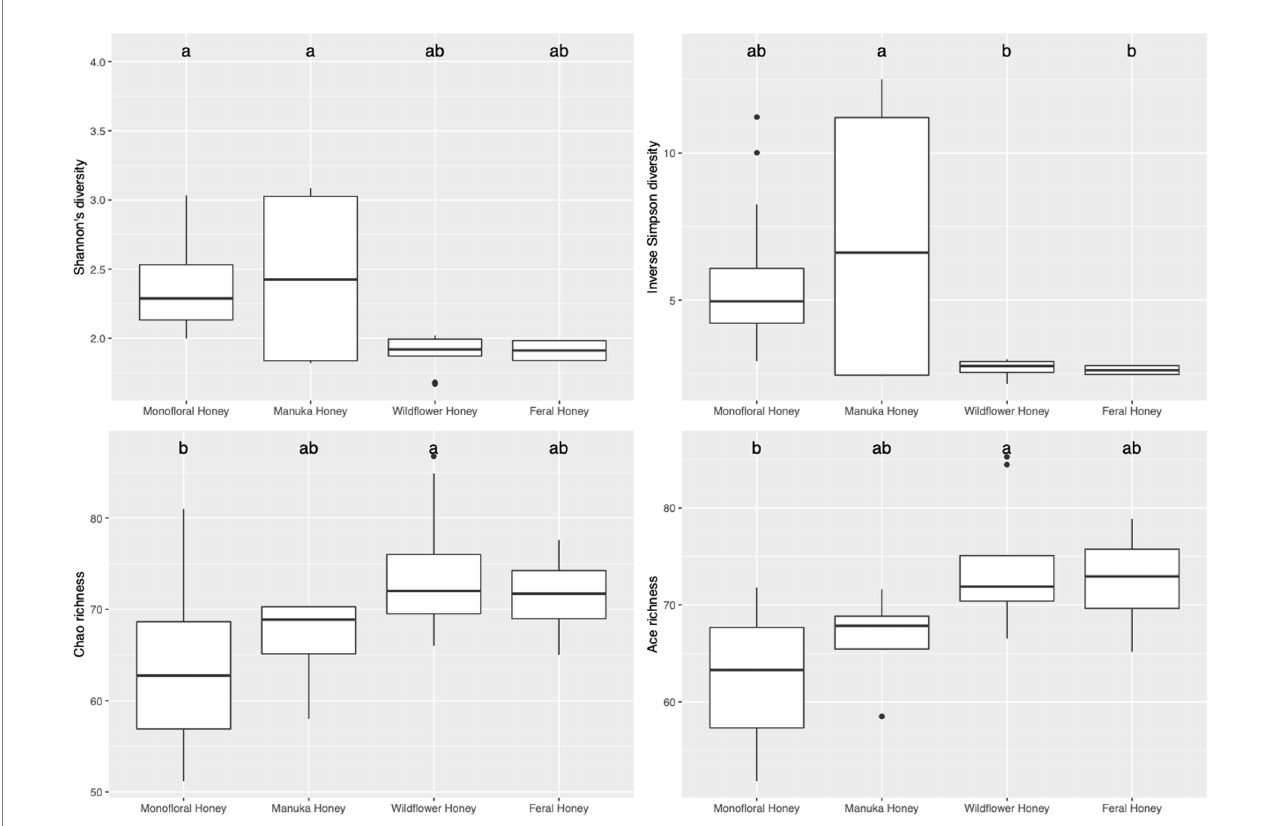
FIGURE 4 Alpha diversity metrics of honey bacterial community. Diversity was measured with Shannon and inverse Simpson indices. Richness was measured with Chao and ACE indices. Comparison between honey sample types was performed with ANOVA and Tukey’s honest significance test. Letters above the bar plots represented shared significance groups ( p -value cutoff is